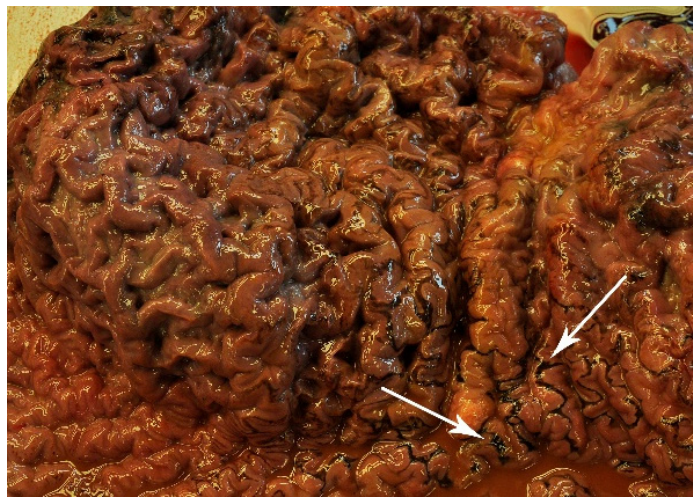
Figure 7. Ulcerations found in the main stomach during the necropsy of a Sowerby’s beaked whale ( Mesoplodon bidens ) that died in 2019 (Specimen 3). Photo: SVA.